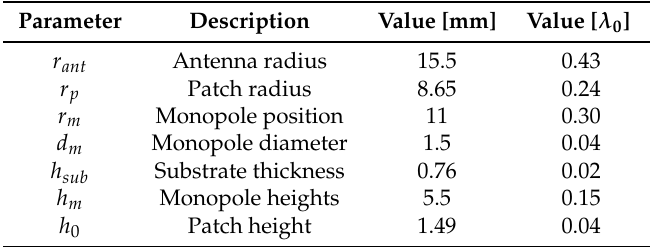
Table 2. Single patch antenna geometric parameters ( f = 8.25